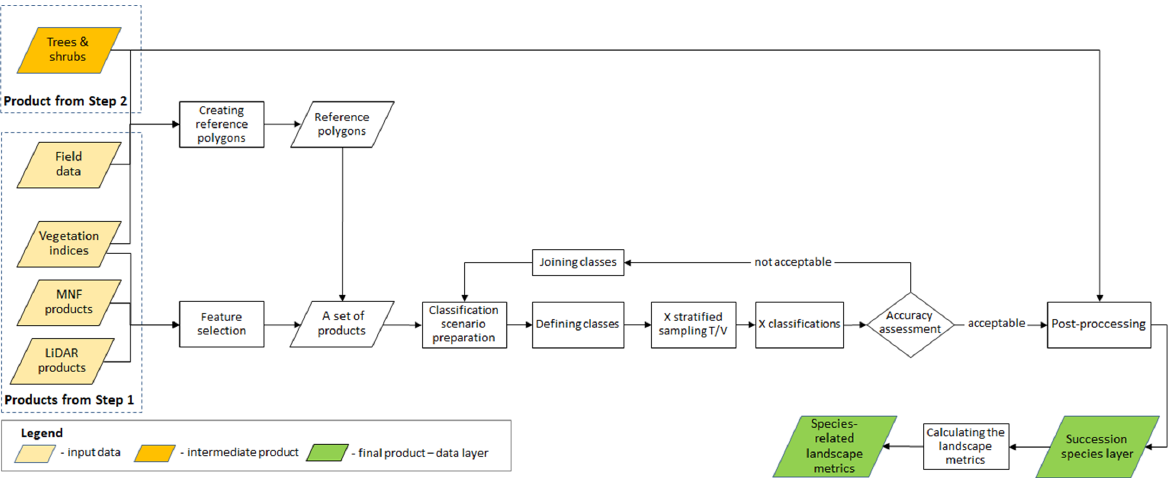
Figure 7. Scheme of Step 5—determining the level of threat of succession for selected individual habitats based on species composition.